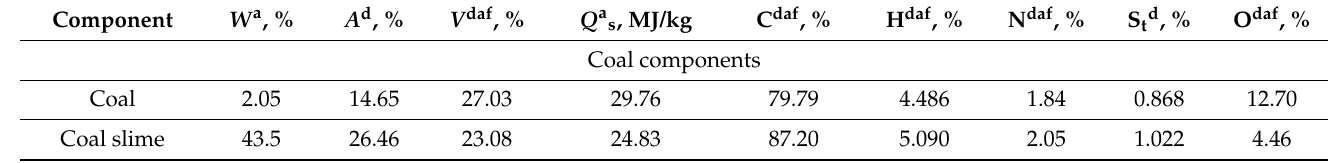
Table 3. Proximate and ultimate analysis of components used in the experiments.